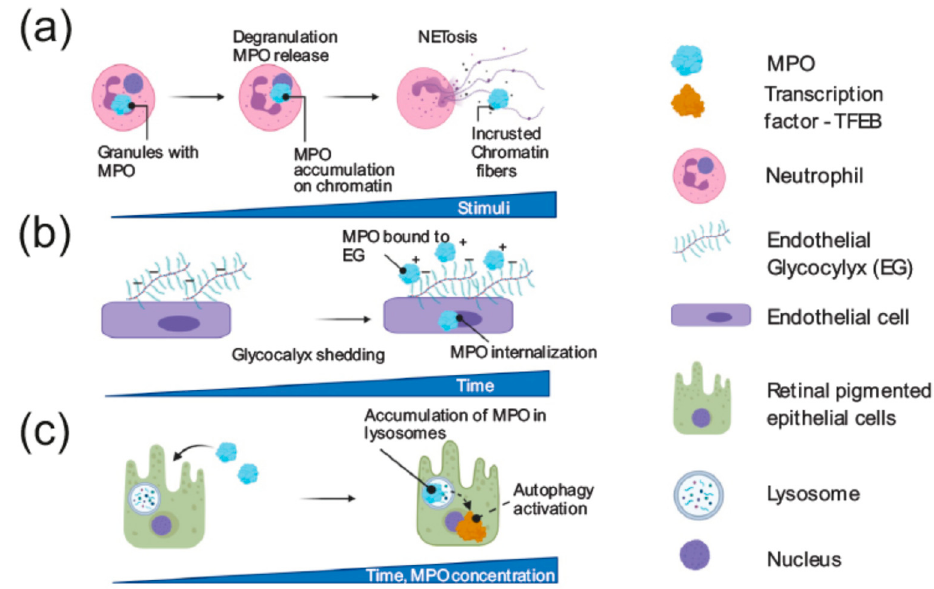
Figure 4. Neutrophil extracellular trap (NET) formation and non-enzymatic modes of MPO effects in different cell types. ( a ) MPO is important for NET formation. Stored in azurophilic granules of rested neutrophils, MPO is released upon various stimuli, contributes to the formation of NETs, and becomes part of NETs when encrusting the chromatin. ( b ) Due to its cationic charge, MPO shows a high affinity towards negatively charged endothelial glycocalyx. Moreover, MPO is internalized by endothelial cells. ( c ) In retinal pigmented epithelial cells MPO is internalized and accumulated in lysosomes leading to activation of autophagy.